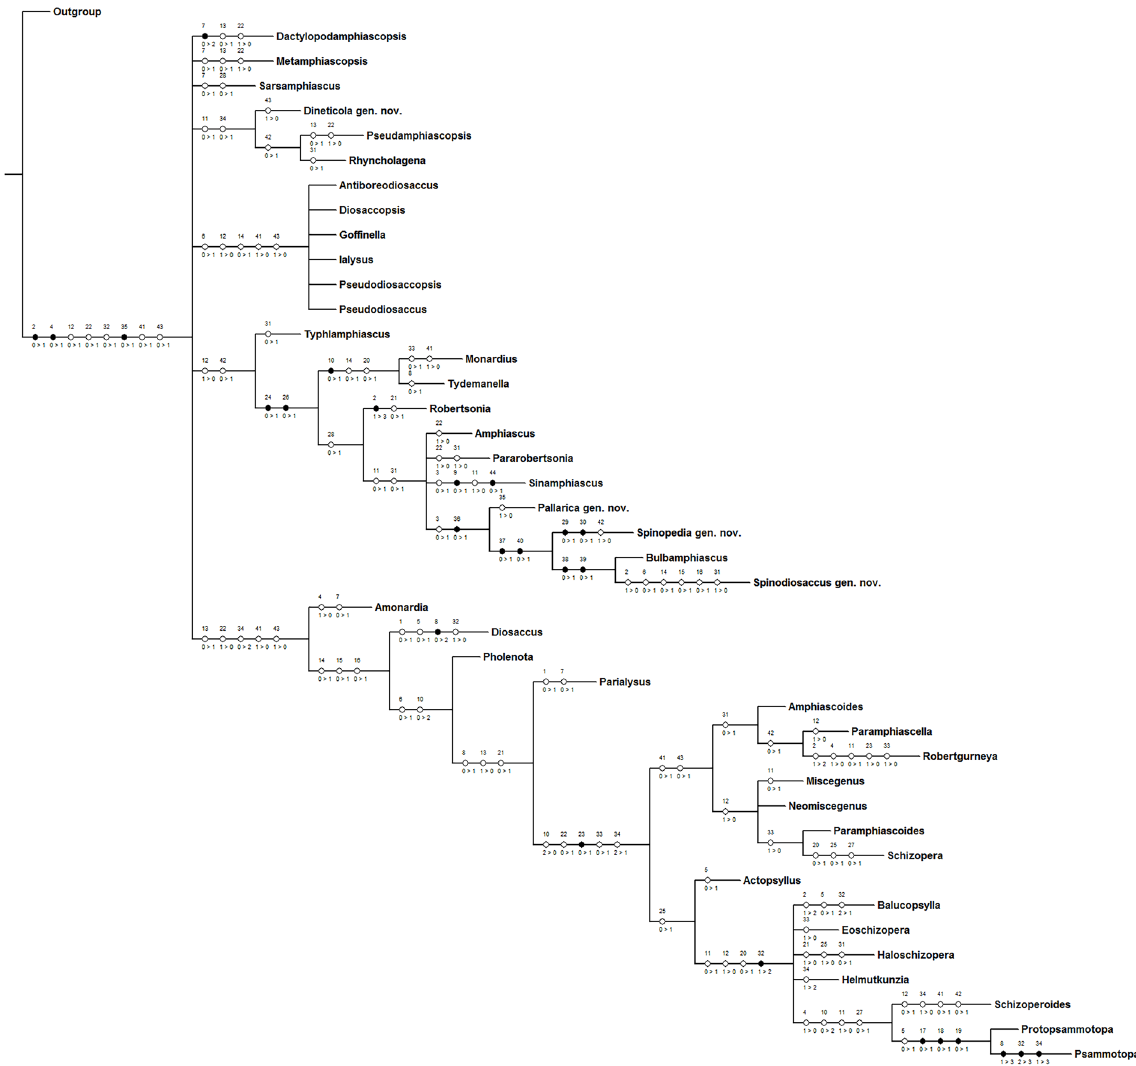
Fig. 19. Strict consensus cladogram of the generic relationships within the